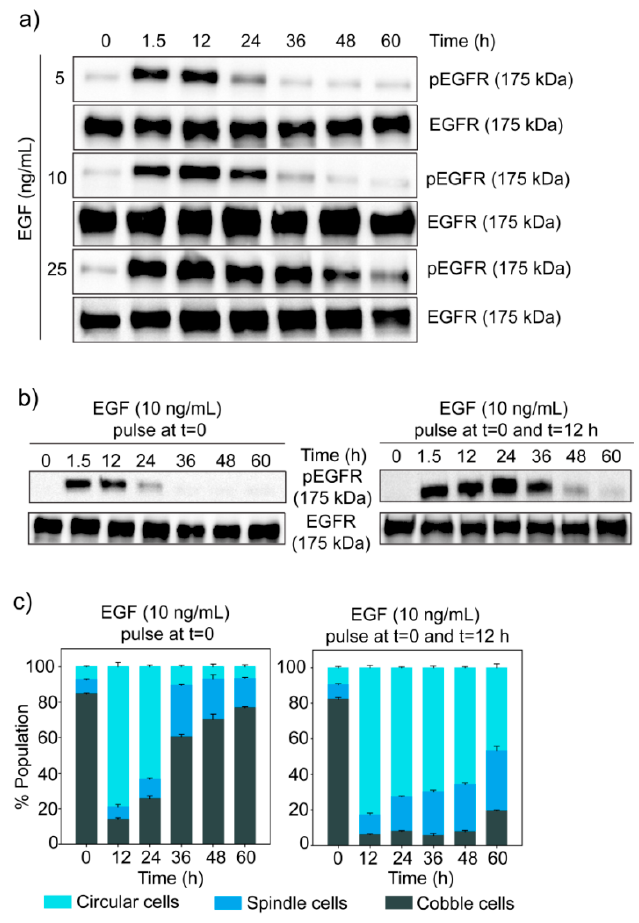
Figure 5. Temporal dynamics of phospho-EGFR in EGF treated MDA-MB-468 cells. ( a ) Cells were treated with di ff erent doses of EGF and phosphorylation of EGFR was measured at di ff erent time points by Western blotting. The experiment has been repeated three times and images of a representative experiment are shown. ( b ) MDA-MB-468 cells were given two pulses of EGF, and phospho-EGFR levels at di ff erent time points were measured by Western blotting. ( c ) Population distribution of MDA-MB-468 cells treated with two pulses of EGF. The graph represents data from quantitative image analysis. Each data point represents the mean of three independent experiments and error bars indicate standard deviation.